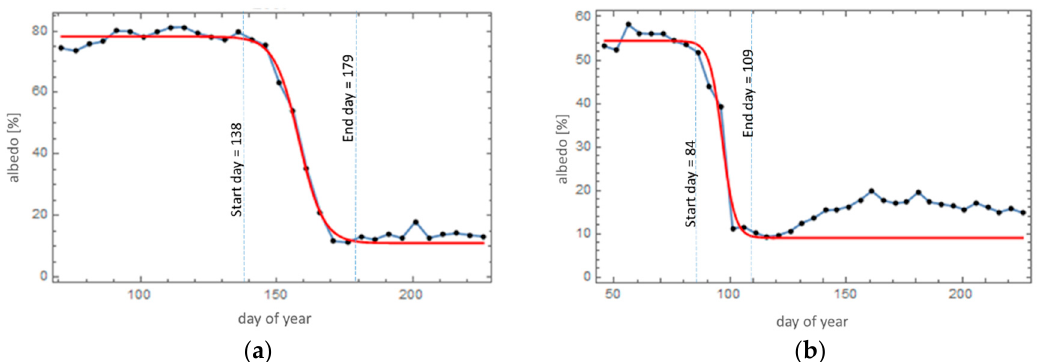
Figure 2. Sigmoid fitting for 5-day mean albedo data for ( a ) location 55.375°N, 47.625°E for year 2006 and ( b ) location 68.125°N, 120.125°E for the year 2007. The growth of vegetation after snow melt is manifested in ( b ) where the albedo values after melt season increase slightly as the vegetation starts to produce leaves.